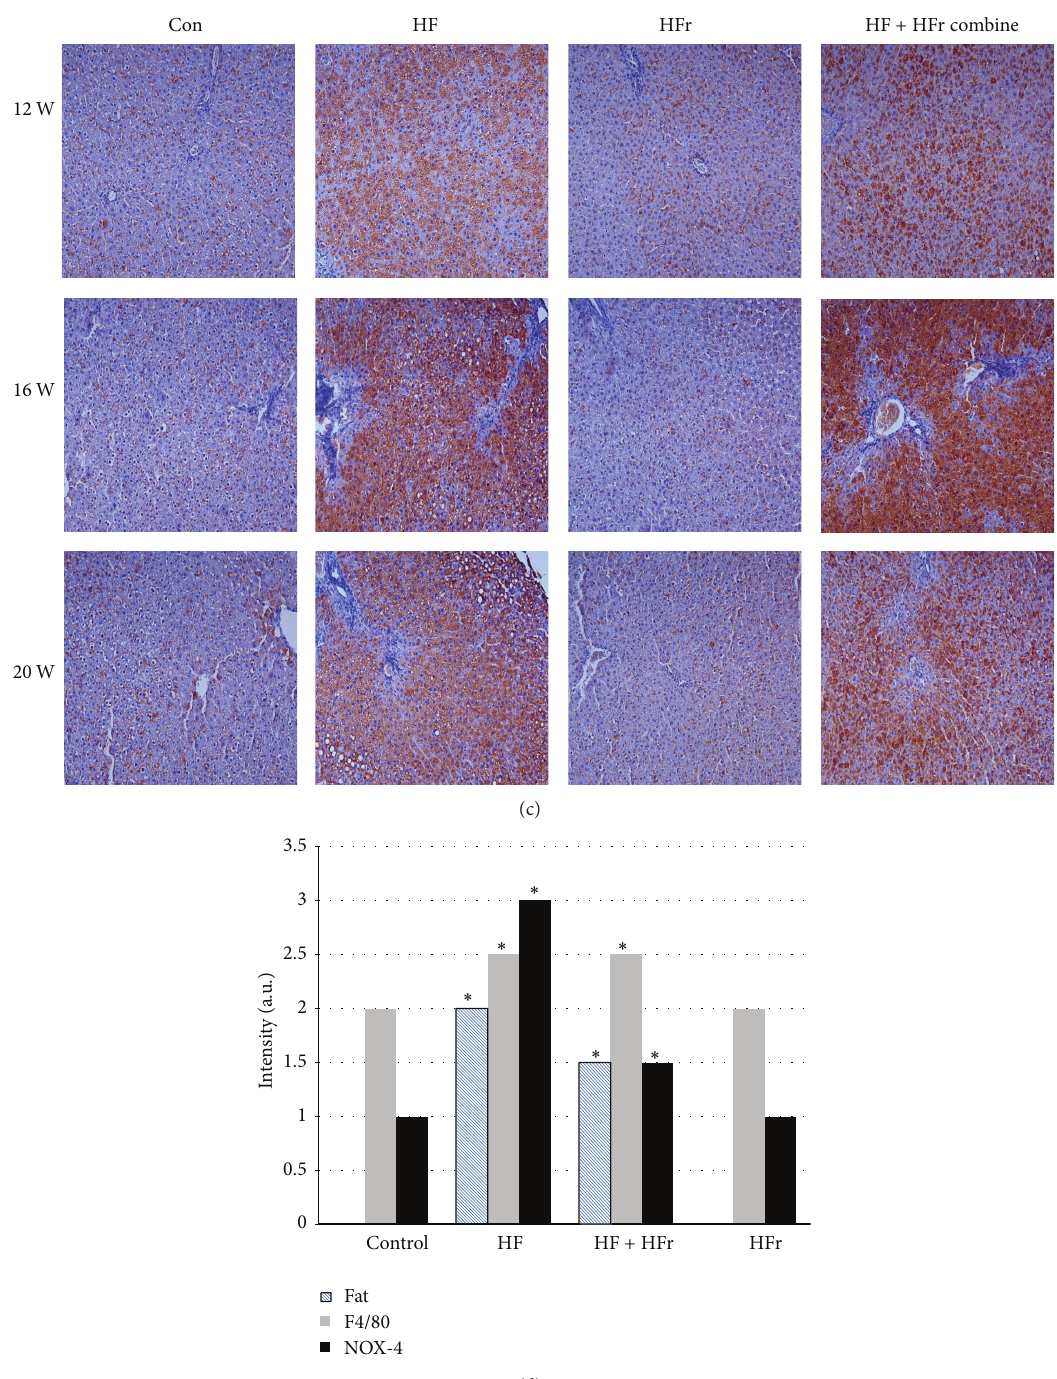
Figure 2: Nonalcoholic fatty liver disease caused by high-fat and high-fructose diet in rats. Histological examination of liver sections by hematoxylin and eosin staining (a) and immunohistochemistry F4/80 (b), NOX-4 (c), and TLR-4 (d).